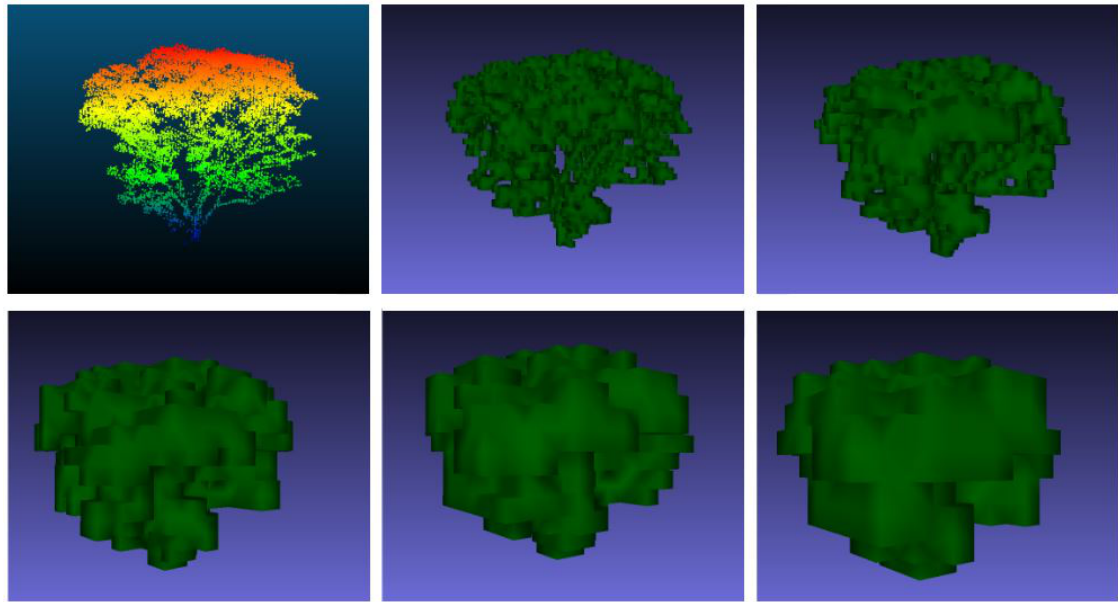
Figure 4. Impact of voxel size on mallee modelling. From right to left - a) point cloud model of a mallee tree in CloudCompare, b) voxel model of the mallee tree with 0.4 m voxel size, c) voxel model of the mallee tree with 0.6 m voxel size, d) voxel model of the mallee tree with 1.0 m voxel size, e) voxel model of the mallee tree with 1.2 m voxel size, f) voxel model of the mallee tree with 1.6 m voxel